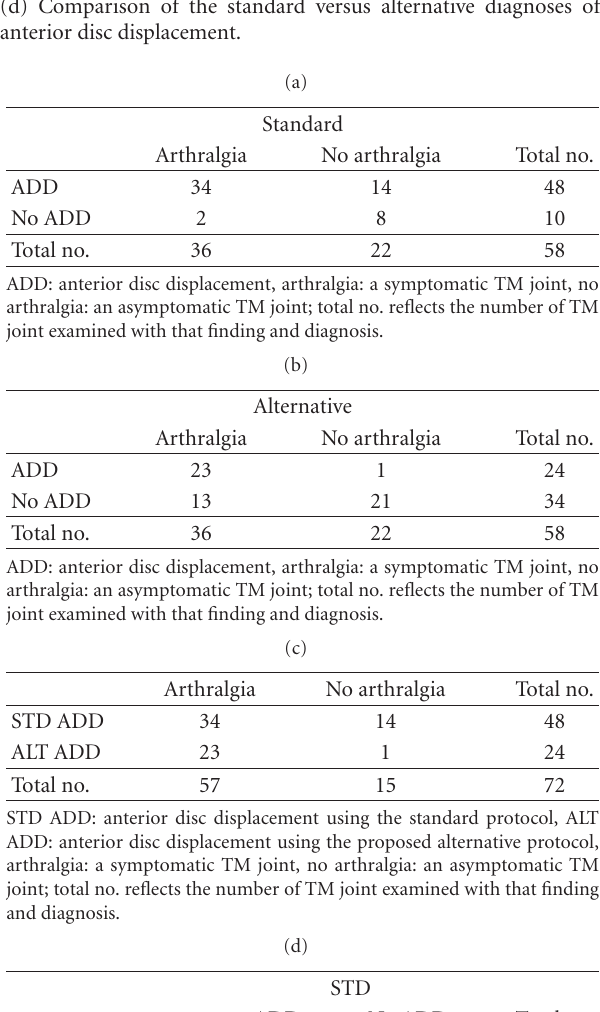
Table 1: (a) The relationship of anterior disc displacement, diag- nosed by the standard protocol, to arthralgia. (b) The relationship of anterior disc displacement, diagnosed by the alternative protocol, to arthralgia. (c) Comparison of the relationship of anterior disc displacement, standard versus alternative diagnoses, to